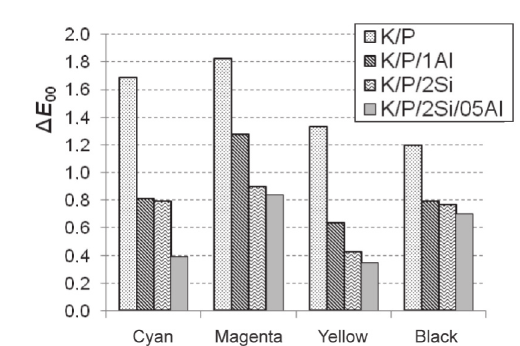
Fig. 5 – Color difference ΔE of cyan, magenta, yellow and 00 black after PCL and PCL coating modified with SiO and Al O nanoparticles 2 2 3